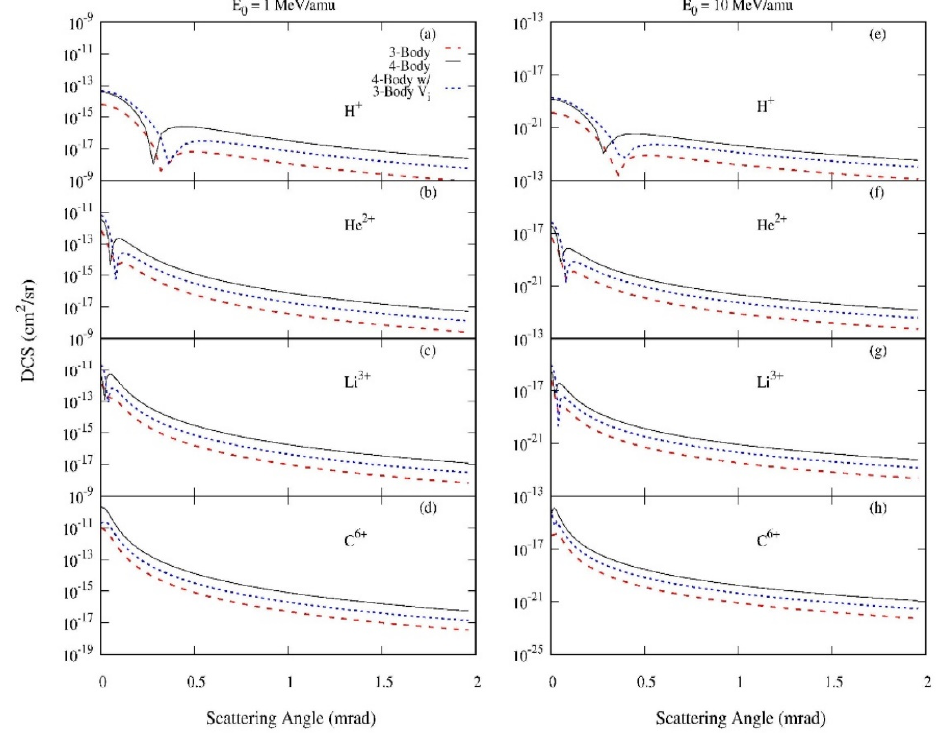
Figure 3. Same as Figure 3, but results are included for the four-body model using the three-body perturbation of Equation (17), as described in the text.